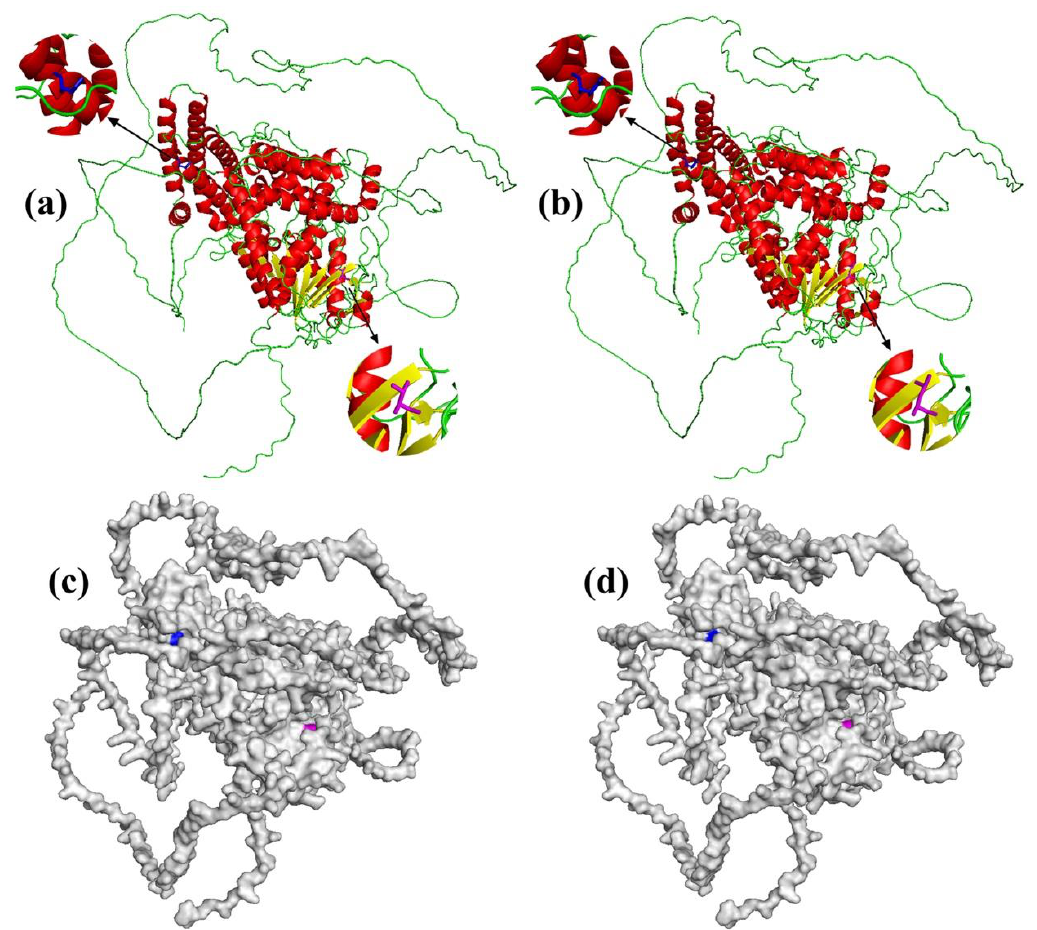
Figure 5. Visualization of Tyr393His and Leu567Val in LIPE: ( a ) cartoon representation of human; ( b ) cartoon representation of sperm whale; ( c ) surface representation of human; ( d ) surface repre- sentation of sperm whale. Table 2. Sperm-whale-specific missense mutations in LIPE. Gene